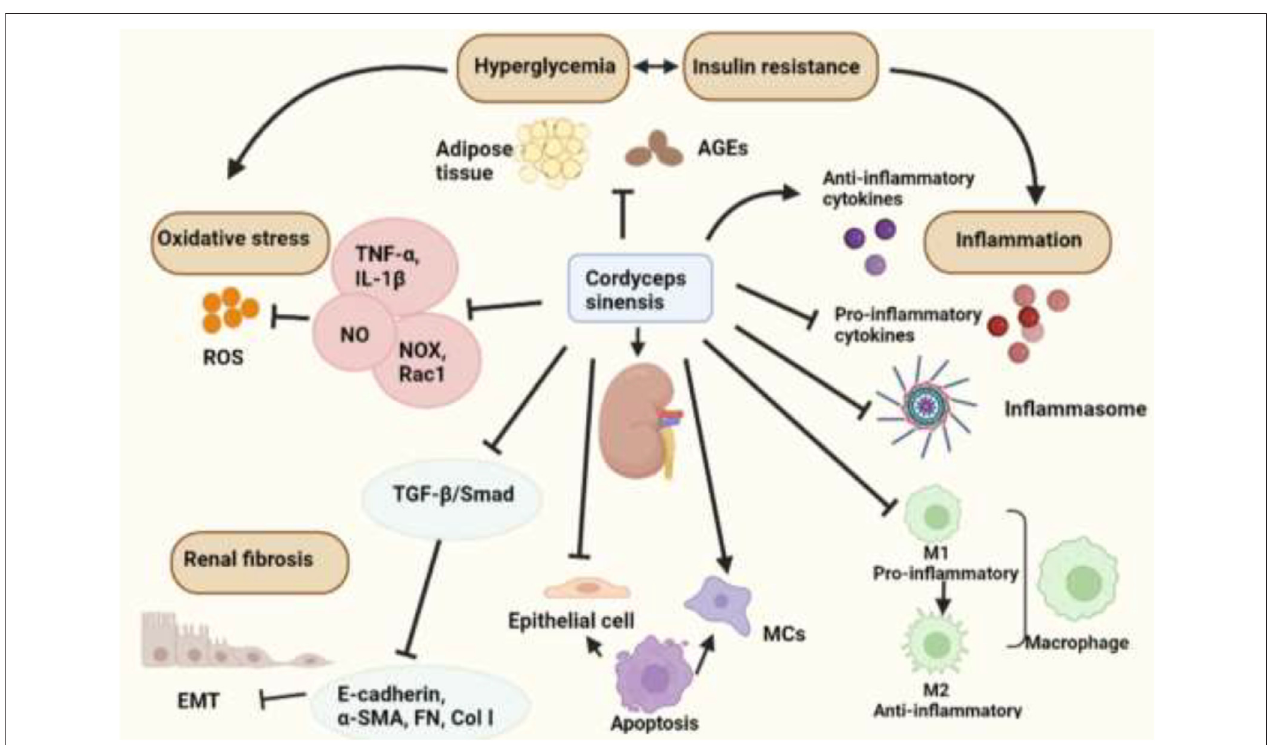
FIGURE 2 | The biological activities of Cordyceps sinensis in treating